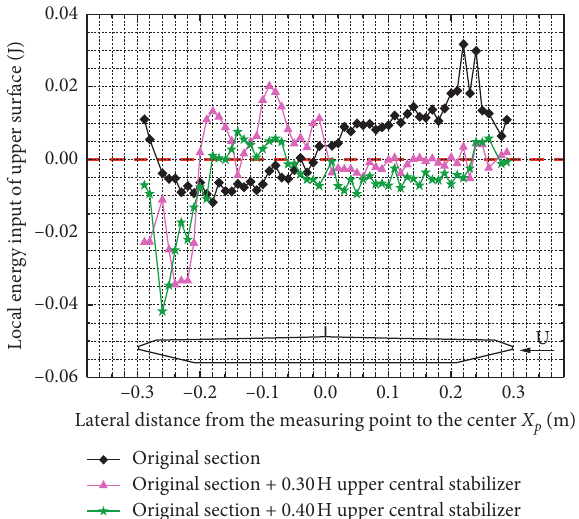
Figure 13: Local energy input of the upper surface.